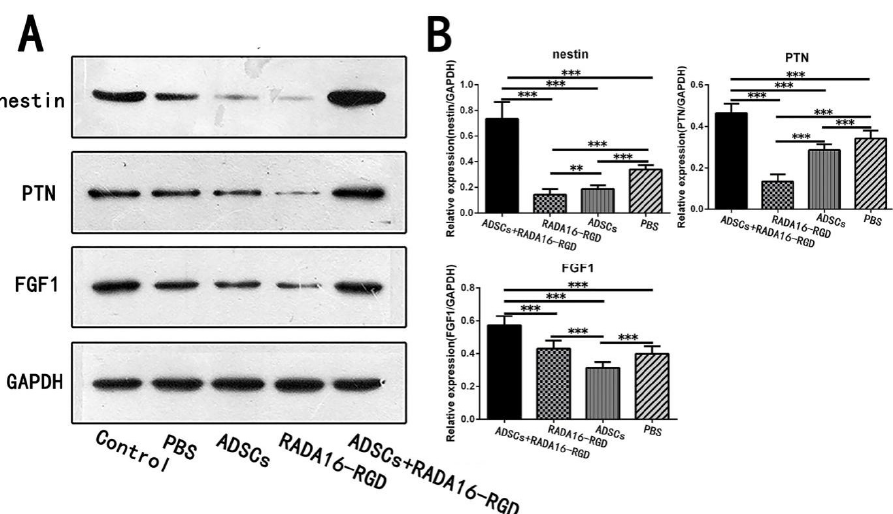
Figure 11. Expression of the selected proteins in week 2 as assessed by Western blotting. ( A ) Expres- sion of nestin, FGF1, and PTN proteins in the second week by Western blotting. ( B ) Quantification of the relative protein expression. The expression of nestin in the ADSCs+RADA16-RGD group was significantly higher than that in the PBS, ADSCs, and RADA16-RGD groups (ADSCs+RADA16-RGD vs. PBS or ADSCs or RADA16-RGD: p < 0.001), while it was significantly lower in the RADA16-RGD group than in the ADSCs and PBS groups (RADA16-RGD vs. ADSCs: p < 0.01, RADA16-RGD vs. PBS: p < 0.001), and significantly lower in the ADSCs group compared to the PBS group (ADSCs vs. PBS: p < 0.001). The expression of PTN was significantly higher in the ADSCs+RADA16-RGD group than in the PBS, ADSCs, and RADA16-RGD groups (ADSCs+RADA16-RGD vs. PBS or ADSCs or RADA16-RGD: p < 0.001), significantly lower in the RADA16-RGD group than in the ADSCs and PBS groups (RADA16-RGD vs. ADSCs or PBS: p < 0.001), and significantly lower in the ADSCs group than in in the PBS group (ADSCs vs. PBS: p < 0.001). The expression of FGF1 was significantly higher in the ADSCs+RADA16-RGD group than that in the PBS, ADSCs, and RADA16-RGD groups (ADSCs+RADA16-RGD vs. PBS or ADSCs or RADA16-RGD: p < 0.001), and significantly lower in the ADSCs group than that in the RADA16-RGD and PBS groups (ADSCs vs. PBS or RADA16-RGD: p < 0.001). ** p < 0.01, *** p < 0.001. Data are presented as mean ± SEM ( n = 3 per group). ADSCs: